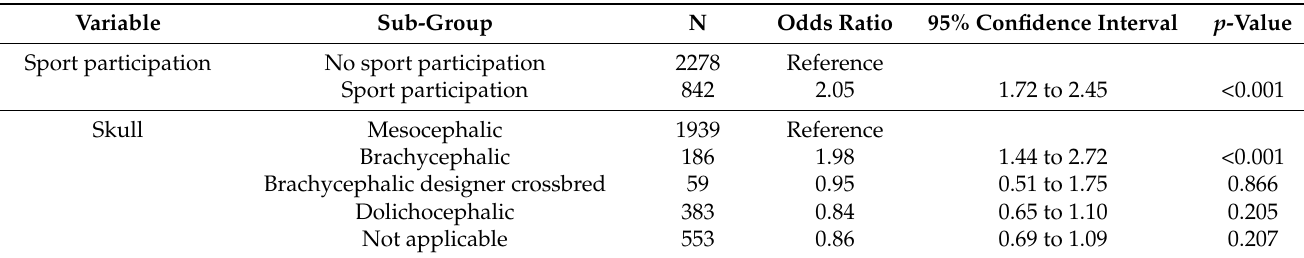
Table 9. Mitigation model 3, use of cooling aids (such as cooling coats) in summer: canine variables tested through binary logistic regression for their association with coat use in winter to facilitate activity. Increased odds of coat use are indicated by an odds ratio greater than one; an odds ratio lower than one indicates reduced odds of coat use.